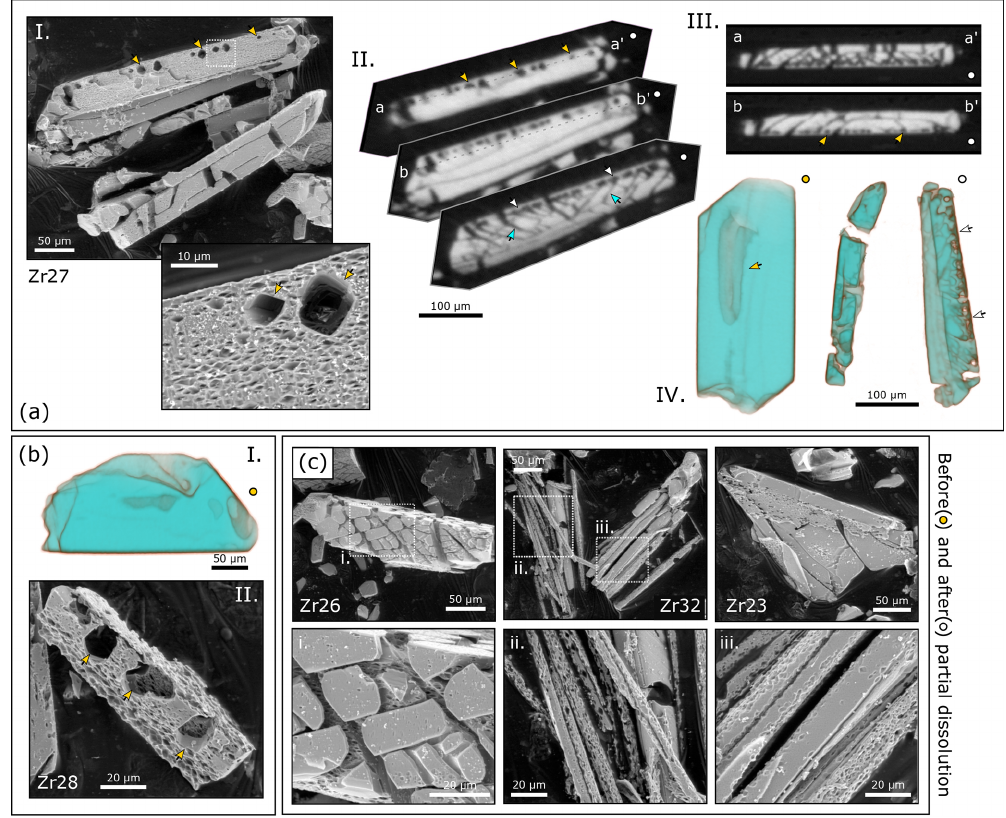
Figure 11. SE and µCT images of AS3 pre- and post-chemical abrasion at 180 ◦ C for 12h. (a) Subpanel (I) shows SE images of sample Zr27, showing a row of dumbbells along the length of the zircon crystal. The higher-magnification SE image shows a sponge-like surface texture. (II) A series of 2D µCT image slices progressively stepping down to view structures beneath the crystal’s surface. The yellow arrows highlight the same dumbbell features marked on the SE image in (I). The teal arrows highlight fractures, many of which radiate from dumbbell features. The white arrows mark another series of dumbbells on the bottom side of the crystal. (III) Cross-sectional 2D µCT image slices of a–a (cid:48) and b–b (cid:48) as labeled in (II). White arrows mark a second set of dumbbells with a different crystallographic orientation. (IV) Semi-transparent 3D rendering of µCT data with arrows highlighting a large melt inclusion. The dissolution of this inclusion likely caused the grain to break into two pieces. The white arrows mark the same row of dumbbells as indicated by the white arrows in (II). (b) Subpanel (I) shows a semi-transparent 3D rendering of µCT data for Zr28. (II) SE image of the husk-like zircon shell with large dumbbell features. (c) SE images of zircon residues Zr26, Zr32, and Zr23 showing cobblestone-, straw-, and lace-like